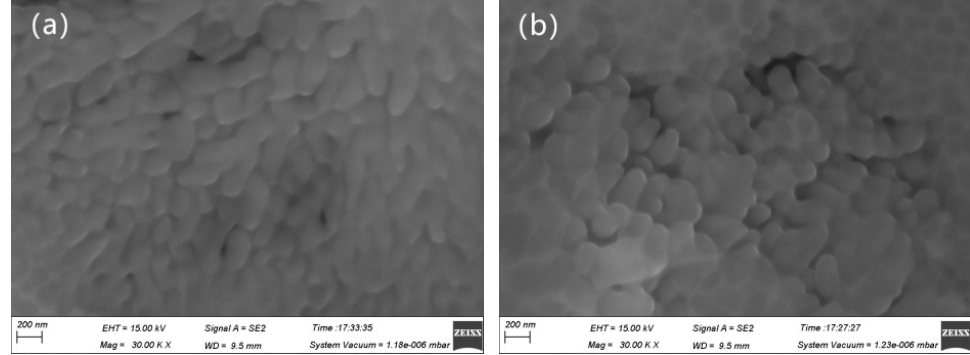
Figure 7. Microstructure of the foil-like brazing filler metal: ( a ) microstructure of the free surface; ( b ) microstructure of the near-roller surface.